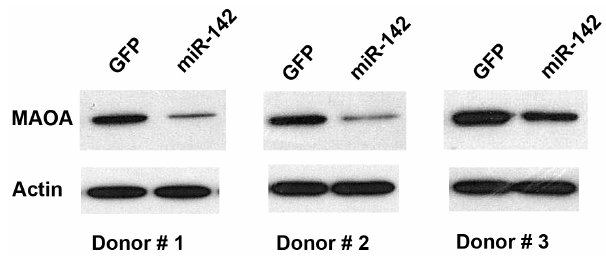
Figure 2. miR-142 downregulates MAOA protein expression in human neurons. Human neurons grown in vitro for 11 days were transduced with either miR-142 or GFP lentivirus. On day 6 after transduction, cells were harvested and Western blot analysis was performed for MAOA. Representative Western blots from three human neuron donors indicating a decrease in MAOA protein level after miR- 142 transduction compared to control GFP transduction are shown. Quantification of Western blots from 5 human neuron donors revealed a significant decrease in MAOA level after miR-142 transduction (fold change -1.9, p , .05). Blots were normalized to b -actin and paired t-test was